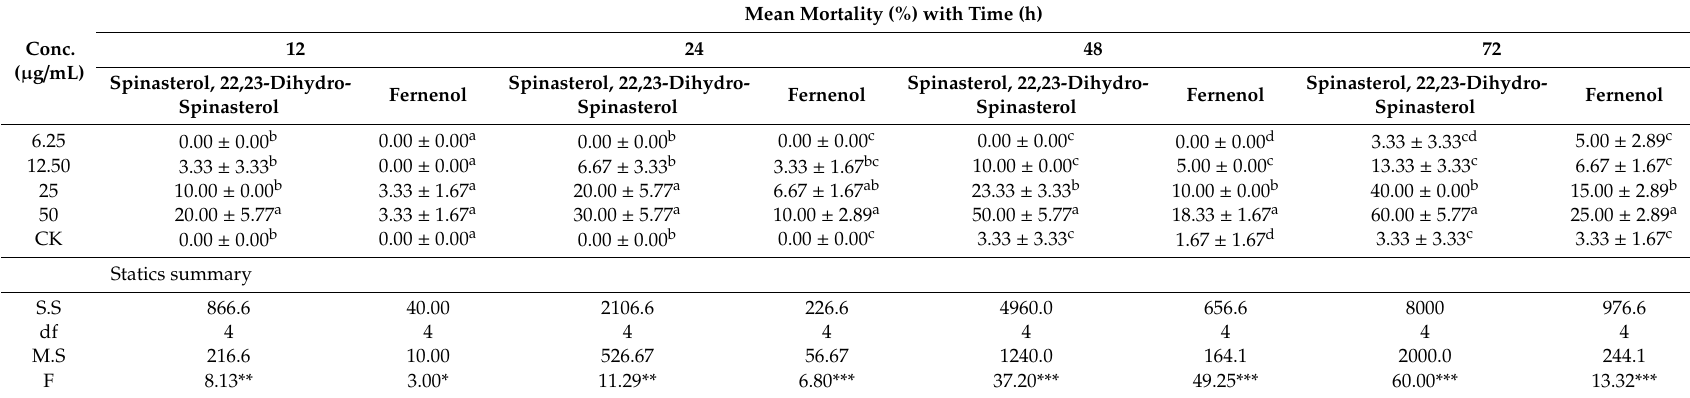
Table 4. Mortality of Brevicoryne brassicae by spinasterol, 22,23-dihydrospinasterol and fernenol via greenhouse